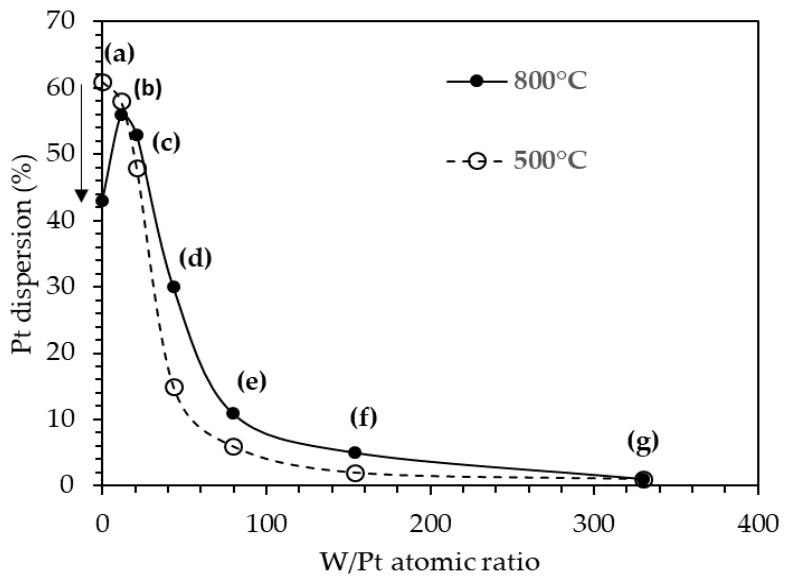
Figure 12. Pt dispersion of the catalysts: ( a ) Pt100A, ( b ) Pt25SA‒0.5W, ( c ) Pt25SA‒1W, ( d ) Pt25SA‒2W, ( e ) Pt25SA‒4W, ( f ) Pt25SA‒8W, and ( g ) Pt25SA‒16W, reduced to 500 and 800 °C.